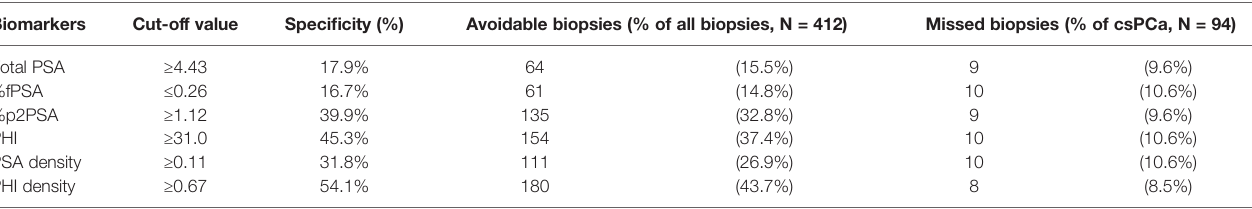
TABLE 3 | Speci fi city, reduction of unnecessary biopsy, and missing positive cases at 90% sensitivity at predicting csPCa. Biomarkers Cut-off